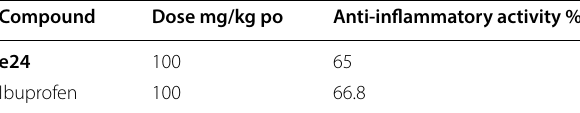
Table 43 Anti-inflammatory of compound e24